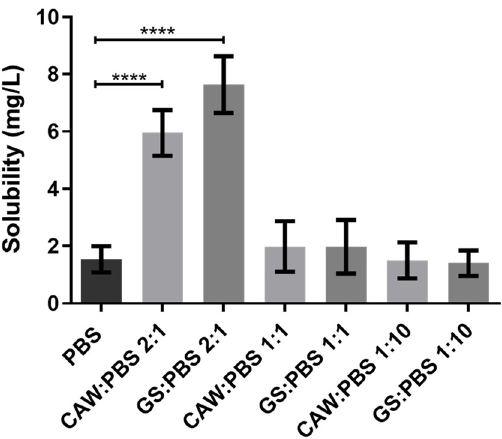
Figure 9. Solubility of celecoxib in PBS and different ratios of GS:PBS and CAW:PBS (2:1, 1:1, and